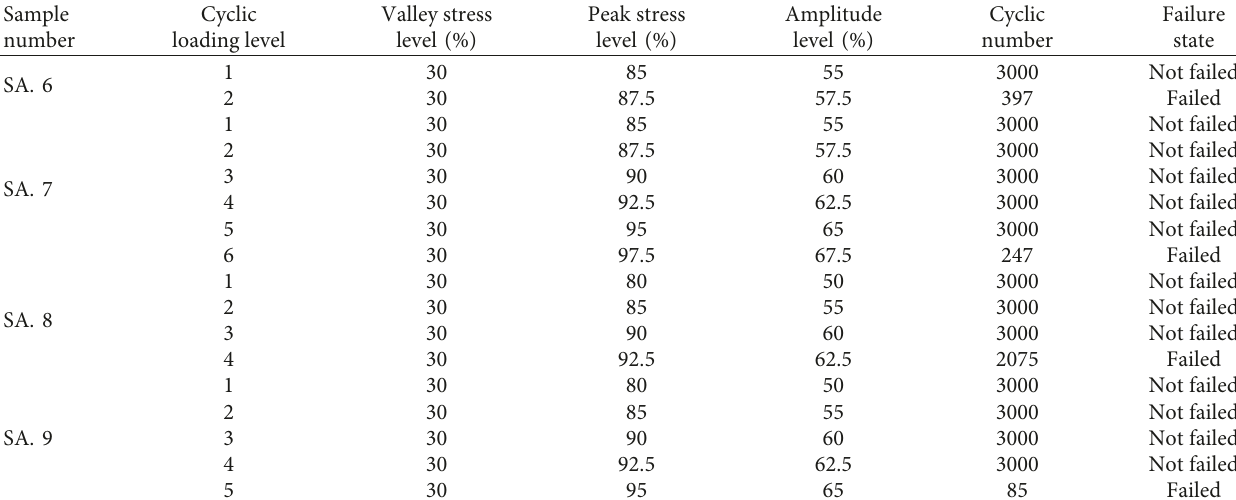
Figure 3: Deviatoric stress-strain curves from the triaxial compression tests of the limestone samples with a single loading rate (0.003mm/s). Table 2: Test conditions and results for the cyclic loading tests.